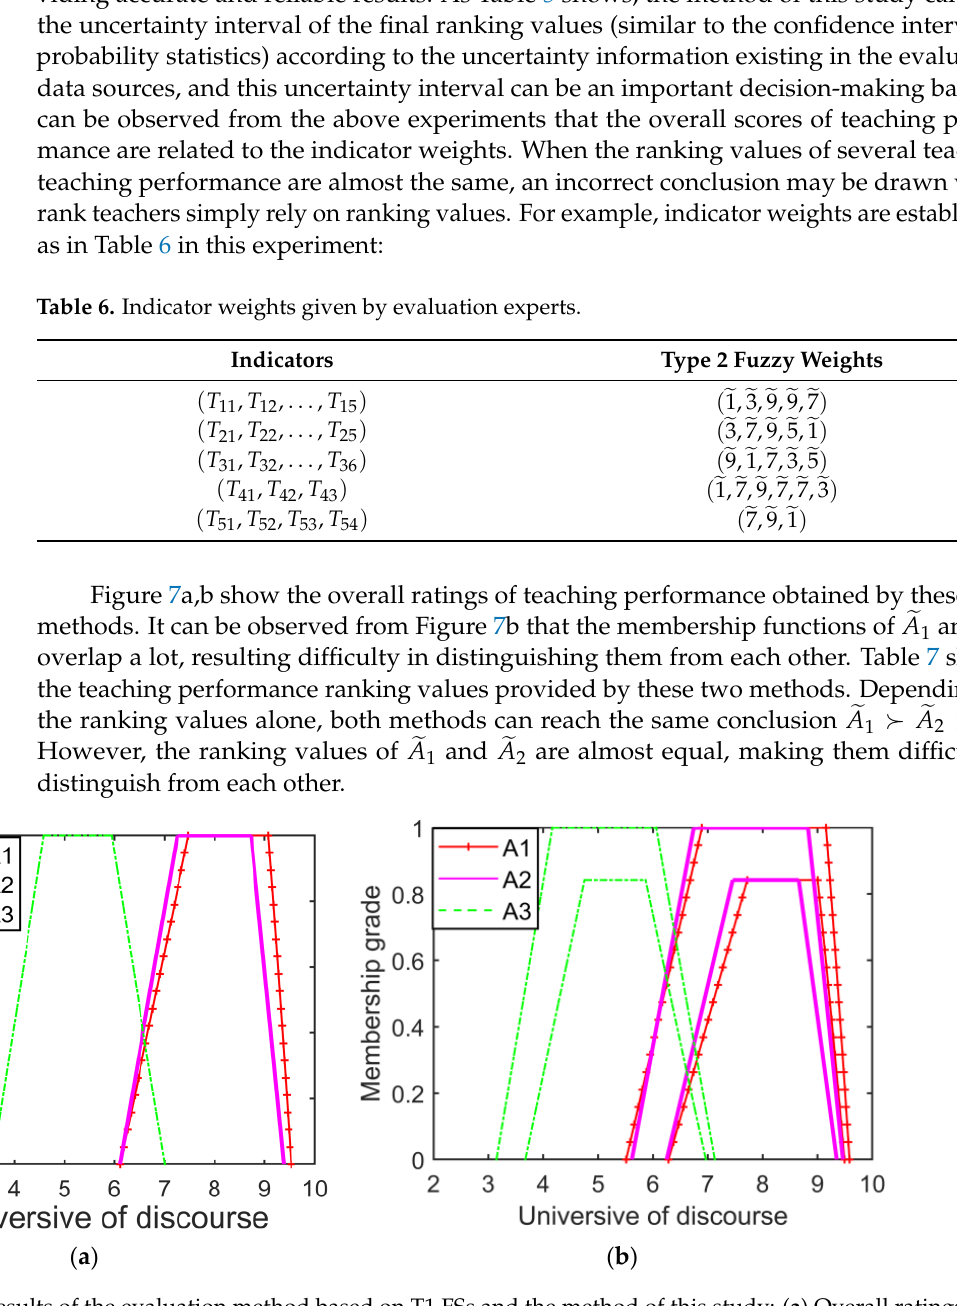
Table 6. Indicator weights given by evaluation experts.